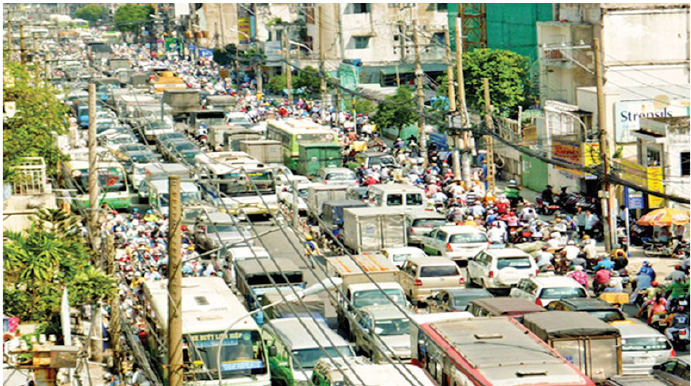
Figure 2. Traffic congestion in Dhaka, Bangladesh.